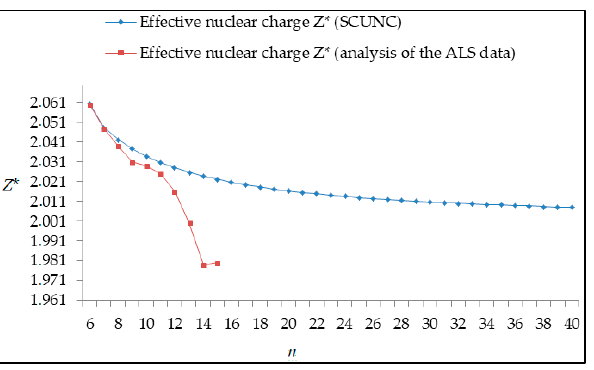
Figure 12. Variations of the effective nuclear charge Z* with the principal quantum number n for the 4 s 2 4 p 2 ( 1 D 2 ) nd ( 2 S ) Rydberg series originating from the 2 P ° 1/2 metastable state of Se + converging to the 3 P 2 series limits in Se 2+ . Table 7. Energy resonances ( E ), quantum defect ( δ ) and effective charge ( Z *) of the 4 s 2 4 p 2 ( 3 P 2 ) nd Ry- dberg series originating from the 4 s 2 4 p 3 2 D° 5/2 metastable state of Se + converging to the 3 P 2 series limit in Se 2+ . The present results (SCUNC) are compared with the experimental data from ALS measurements [6]. The uncertainties in the experimental energies are stated to be ±0.010 eV, f 1 ( 3 P 2 ; 2 D° 5/2 ) = − 0.005 ± 0.001 with ν = 11.